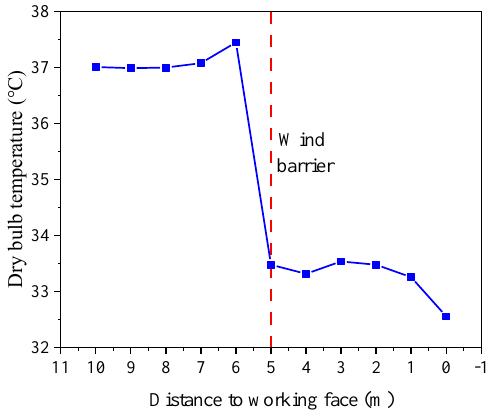
Figure 2. Temperature change diagram of drift centerline.